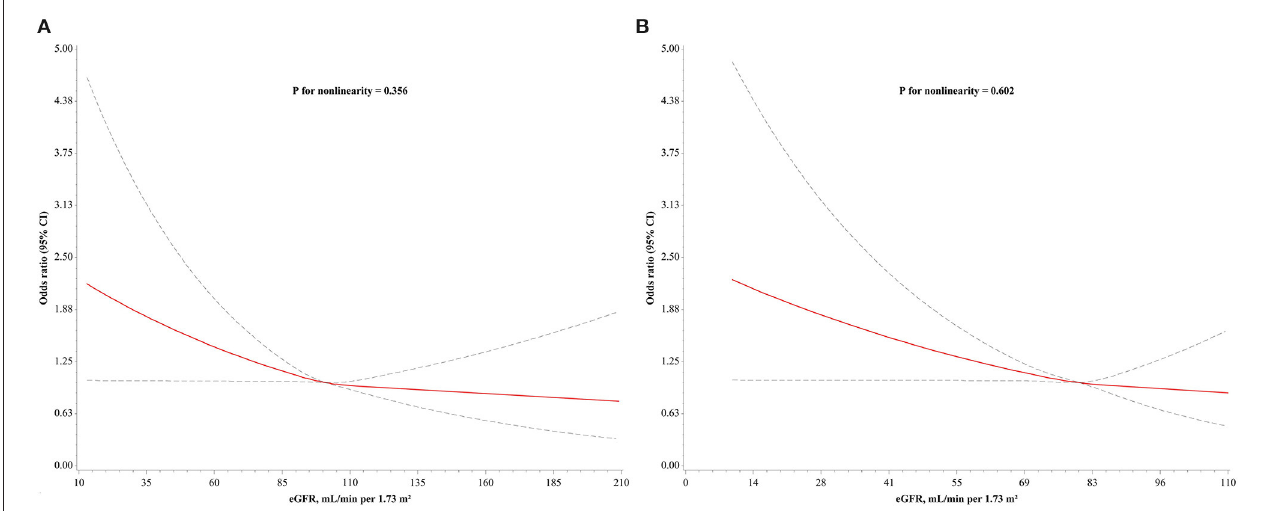
FIGURE 3 | Adjusted dose-response relationship between low HDL-C and eGFR. (A) eGFR calculated using C-MDRD equation; (B) eGFR calculated using CKD-EPI equation. Odds ratios (95% CI) were obtained from restricted cubic splines with knots placed at 25, 50, and 75th percentiles of eGFR distribution. Reference points were median values of eGFR ( A : 101 ml/min/1.73 m 2 ; B : 80 ml/min/1.73 m 2 ). Models were adjusted for age, gender, BMI, smoking, drinking, physical activity, β -blocker, statin, diabetes, liver dysfunction, ASCVD, and triglycerides. Solid line represents odds ratios and dotted lines represent 95% CI. HDL-C, high-density lipoprotein cholesterol; eGFR, estimated glomerular filtration rate; C-MDRD, Chinese Modification of Diet in Renal Disease; CKD-EPI, Chronic Kidney Disease Epidemiology Collaboration; BMI, body mass index; ASCVD, atherosclerotic cardiovascular disease; CI, confidence interval.